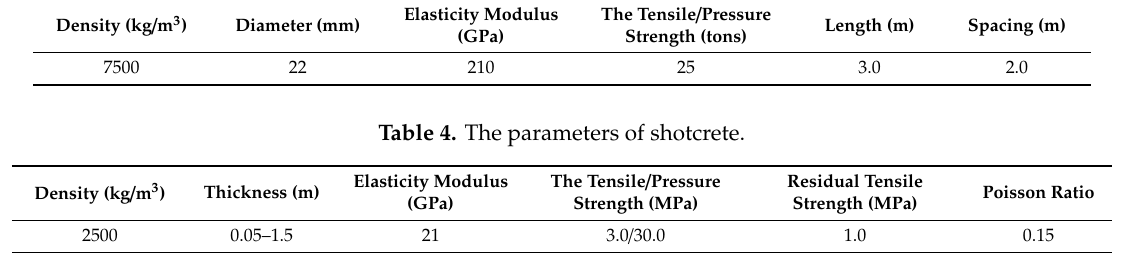
Figure 12. 14-hole advanced stress relief blasting scheme: ( a ) Side view and ( b ) elevation view (mm).